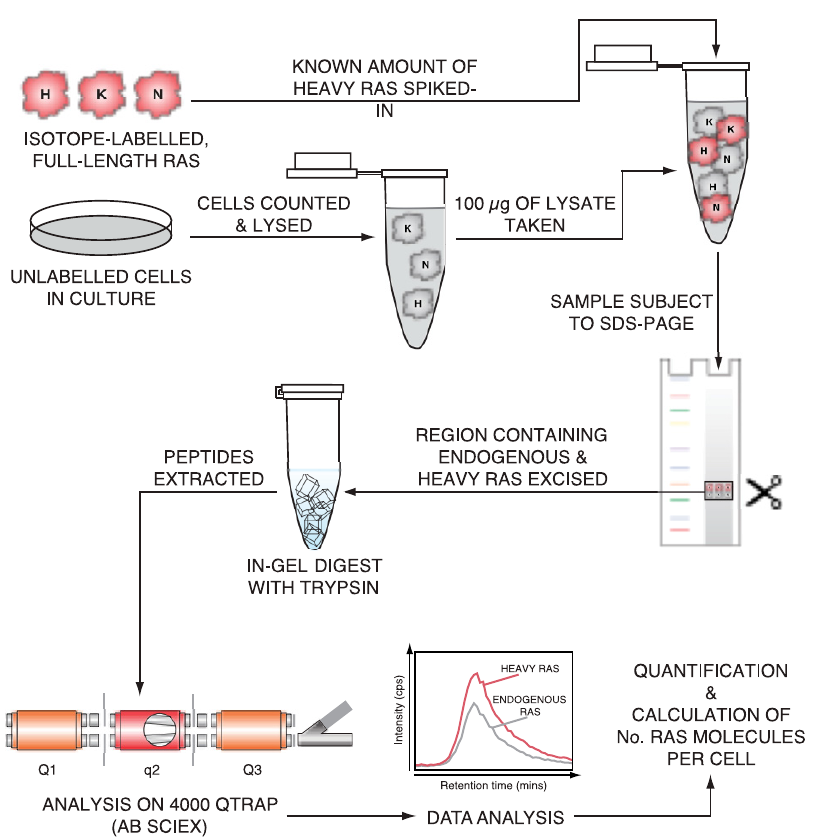
Fig 1. Protein standard absolute quantification for measurement of cellular Ras abundance. Isotopically-labelled Ras proteins are spiked into cell lysates at a known concentration, before fractionation, proteolysis and quantification of pre-defined proteotypic peptides using selected reaction monitoring to allow calculation of Ras isoform